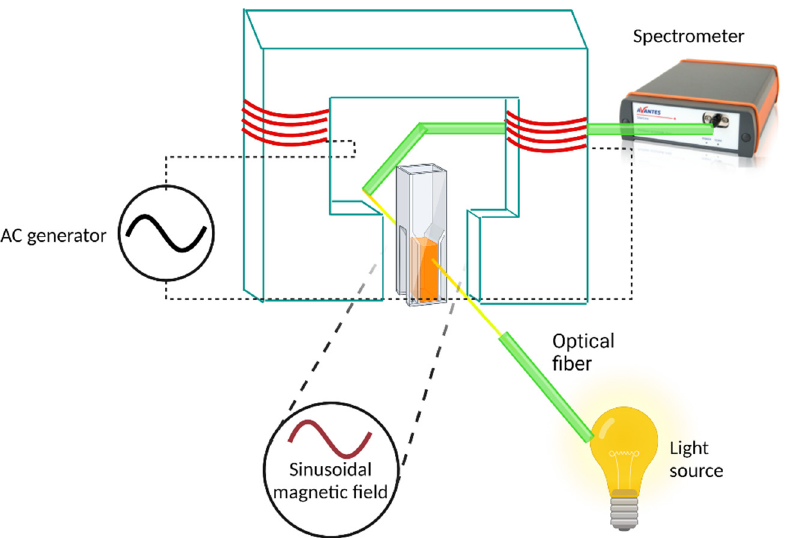
Figure A2. A schematic presentation of Astra-M-Sp instrument for LFMF generator. The set-up contains an original electromagnet with a thermostatic sample volume for a standard photometric cuvette. The electromagnet is connected to the AC generator (California Instruments 2001RP), which can supply 12 A current through the winding. As a result, a sinusoidal magnetic field forms inside the electromagnet air gap. Light beam from the light source (AvaLight DHc, Avantes, Apeldoorn, The Netherland) passes through the cuvette with the help of optical fiber. The intensity of light passed through the cuvette is measured with a spectrometer (AvaSpec 2048, Avantes, Apeldoorn, The Netherland) with the help of optical fiber. This figure was created with BioRender.com (3/12/2021).